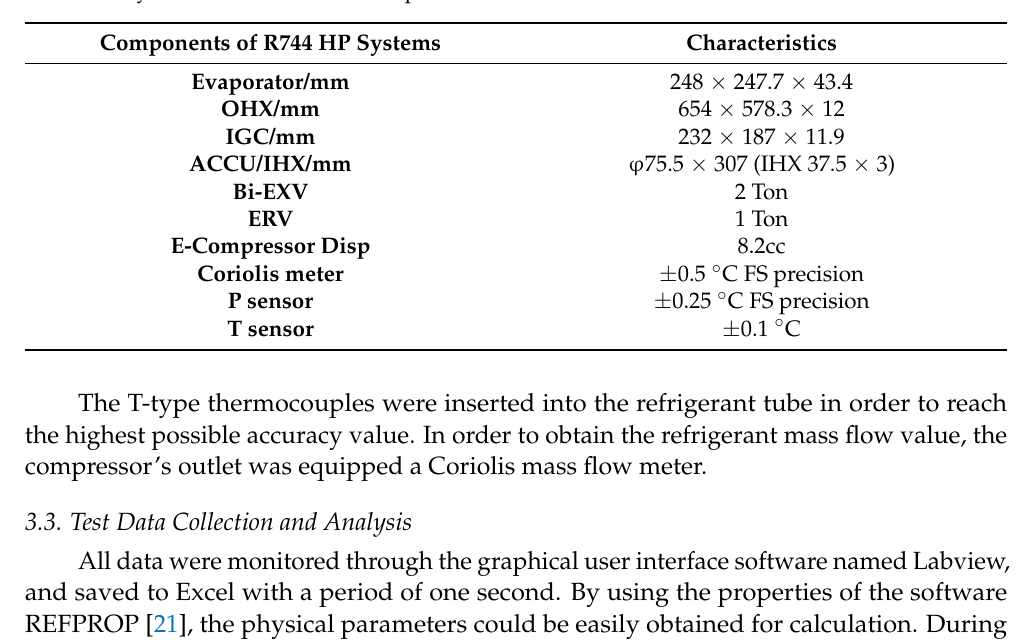
Figure 3. Indoor chamber. Table 1. Key characteristics of the components in the test bench.